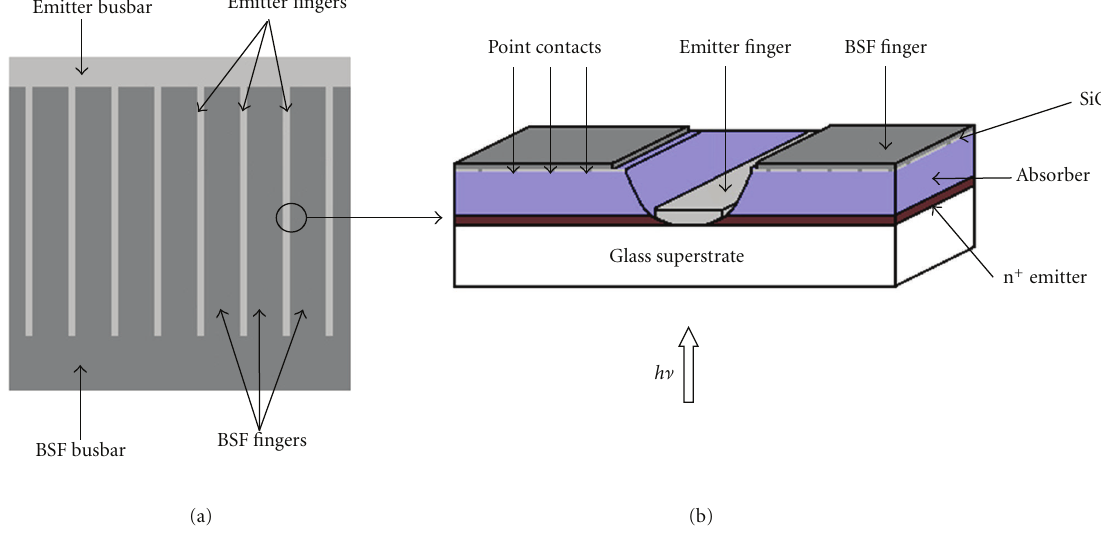
Figure 1: An interdigitated metallization of a poly-Si thin-film solar cell on a glass superstrate. (a) A top-down, “macro” schematic view of a interdigitated-metallized solar cell. The emitter and BSF busbars are used to transport current to an external contact lead, or in the case of series-interconnected modules, to the next cell in the series. (b) An isometric cross-section of an emitter finger, sidewalls, and local BSF finger area. Light (indicated as h υ ) enters from the glass side of the cell.